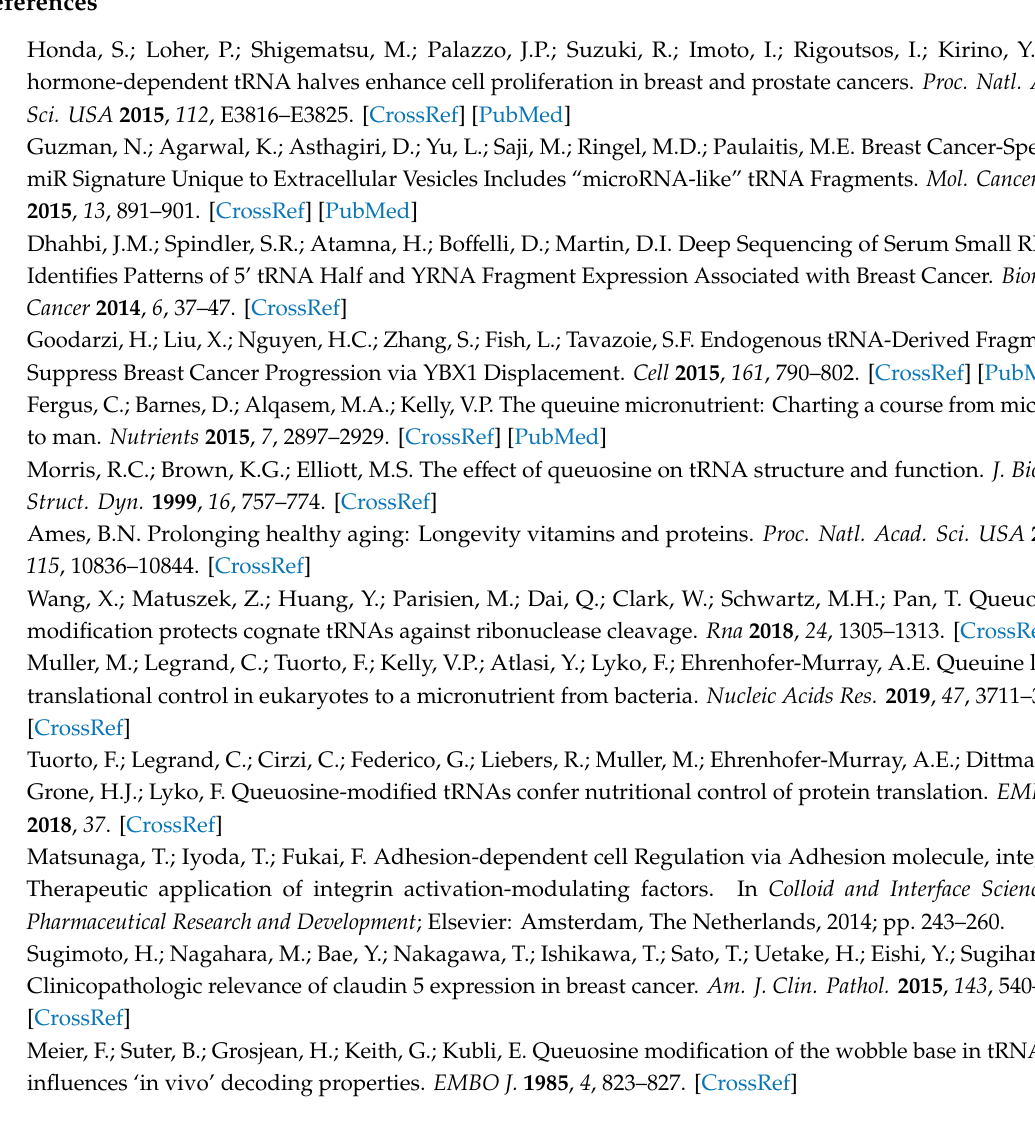
Figure S1. Verification of QTRT1 knockout in MCF7 cells by sequencing and Northern blot. Figure S2. Knockdown of QTRT1 suppressed MDA-MB-231 breast cancer cell proliferation, migration, and altered cell adhesion and tight junctions. Figure S3. Knockdown of QTRT1 suppressed tumor growth and altered tight junctions in tumors in vivo. Figure S4. Altered microbiome in tumors and intestines of nude mouse model. Figure S5. Heatmap of the bacterial percentage abundance in the intestine of nude mice. Figure S6. Relative abundance of intestinal bacteria detected with real-time